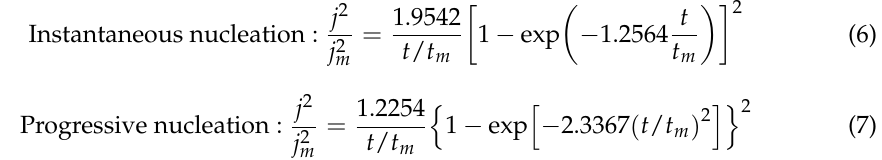
Figure 13. Potentiostatic current transients obtained in the Bi electrodeposition process on the tungsten electrode in ChCl-MA-BiCl 3 at different potentials (T =343 K, c(BiCl 3 ) = 0.10 M). According to the Scharifker–Hills nucleation model, the nucleation/growth mech- anism of the metal deposition process includes instantaneous nucleation (IN) and pro- gressive nucleation (PN) [41]. The ( j / j m ) 2 − t / t m diagram of theoretical instantaneous nucleation and progressive nucleation can be described according to Equations (6) and (7). The experimental data obtained by the chronoamperometry were also subjected to the same dimensionless processing, and the obtained curve is shown in Figure 13.